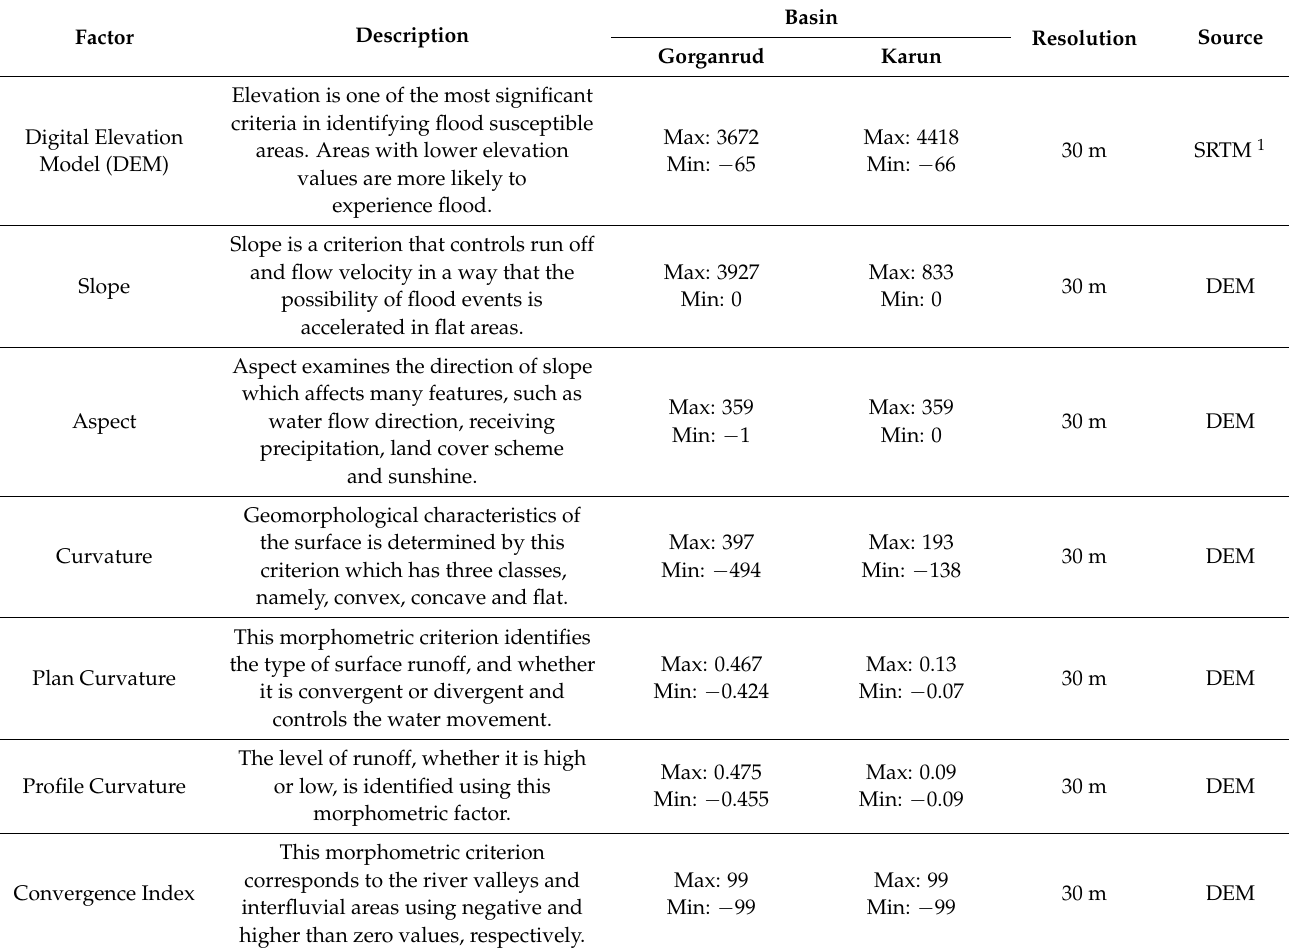
Table 2. Flood conditioning factors which were used in this